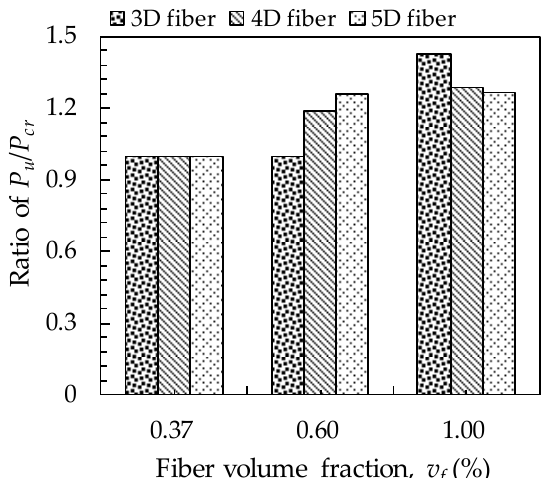
Figure 9. Effects of hooked steel fiber geometry and volume fraction on cracking load and peak load ratio.